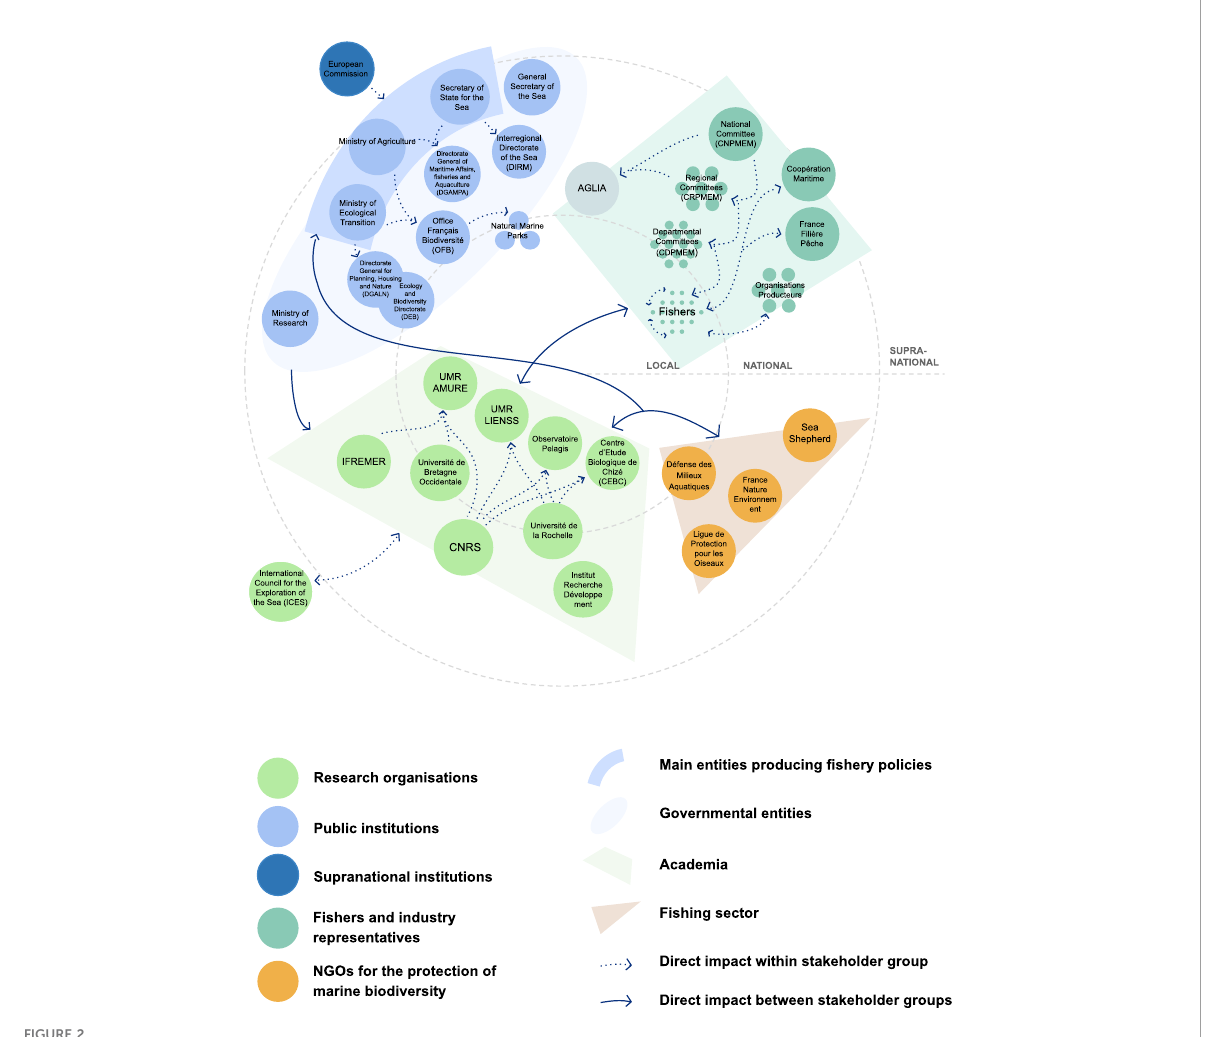
FIGURE 2 Sociogram of the actors ’ system involved in bycatch mitigation in the Bay of